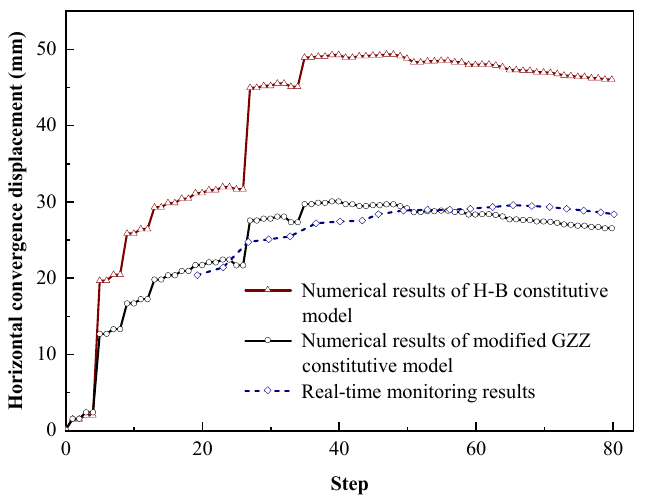
Figure 6. Numerical model. ( a ) meshed tunnel model; ( b ) supporting structures of new constructing tunnel; ( c ) supporting structures of existed tunnel.